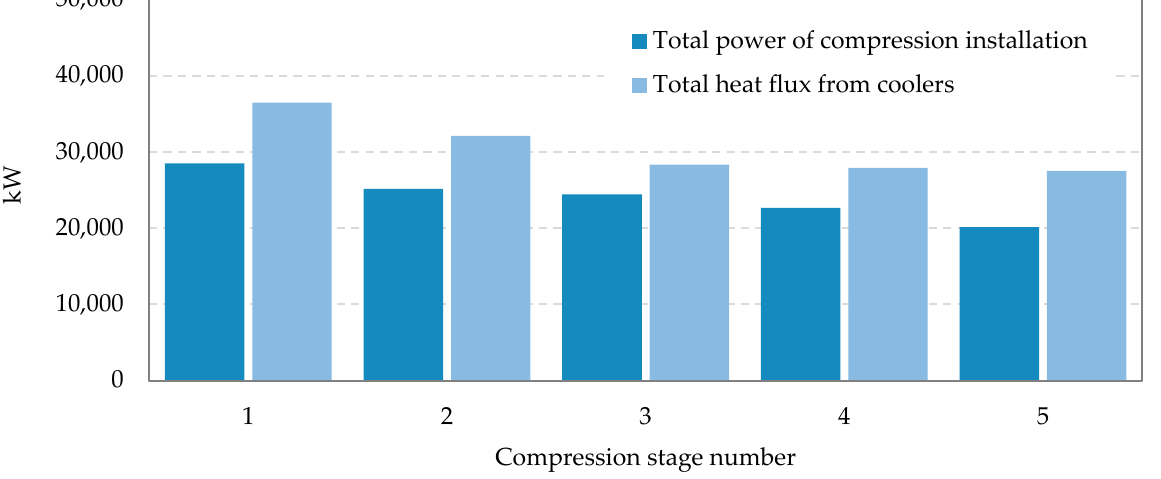
Figure 8. Power demand and heat flux collected in coolers versus the number of compression stages.